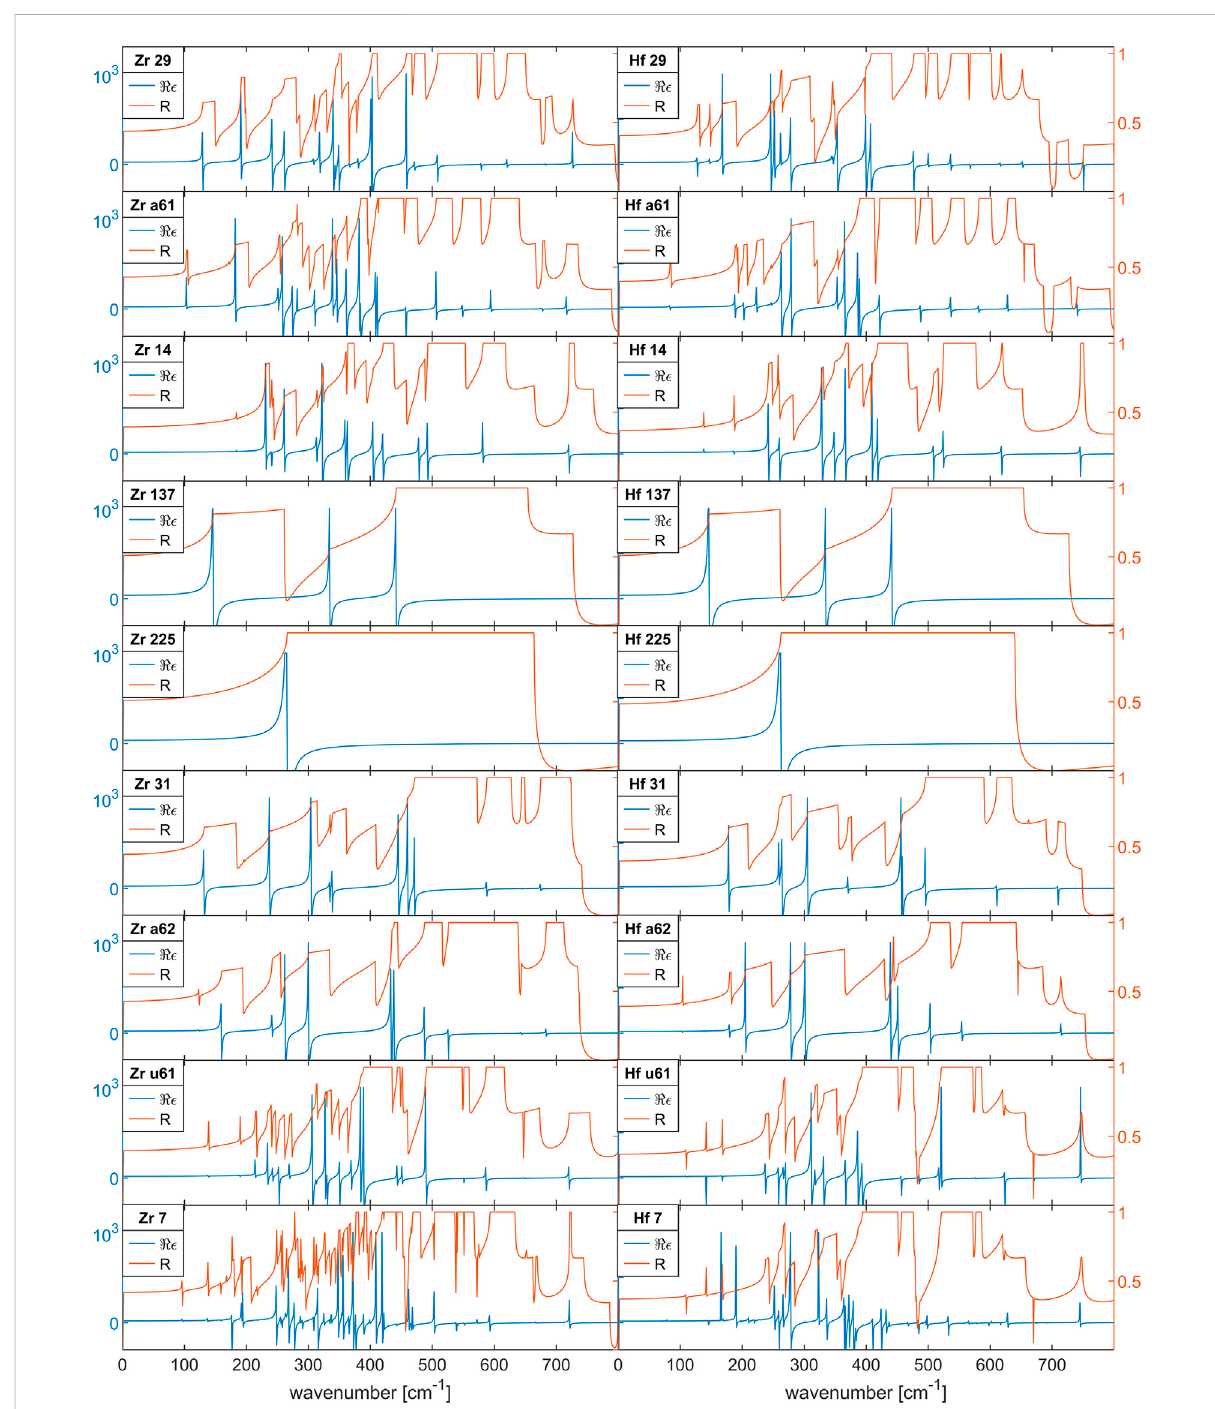
FIGURE 2 Dielectric functions for undoped, polycrystallineZrO 2 and HfO 2 fi lms. The real partof ϵ (blue line) indicates theTO modes as singularity and the LO modes as zeros, the polycristalline re fl ectivity (orange line) indicates TO/LO modes with steep increase/decrease.